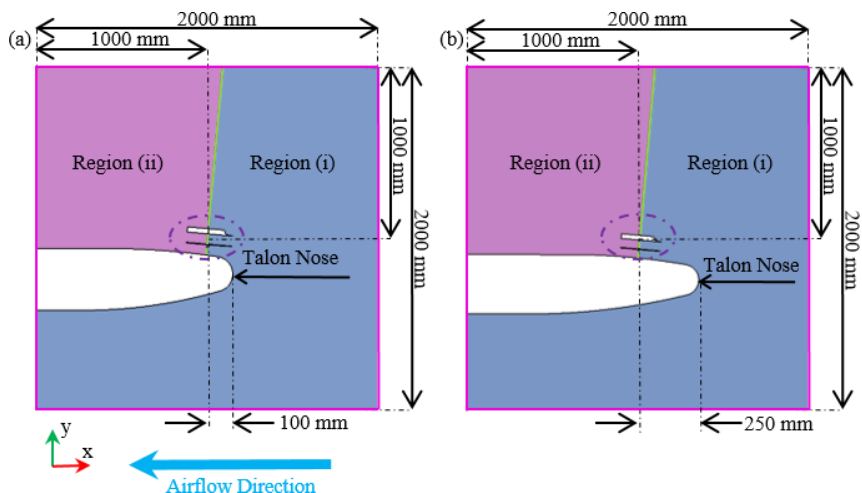
Figure 3. Illustrations of the CFD-LPT domains for the two investigated configurations. Panel (a) shows the fore configuration and panel (b) the aft. The airflow direction and geometrical axes shown in panel (a) are consistent throughout. The UCASS is shown in the dashed purple circle, and the FMI-Talon nose cone is indicated. The purple lines represent free-stream boundaries, and the green line repre- sents the divide between regions (i) and (ii) – which is where the LPT droplets are sampled.